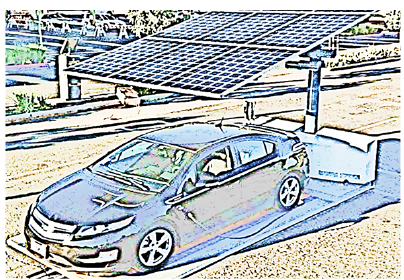
Figure 5. PV parking shade.